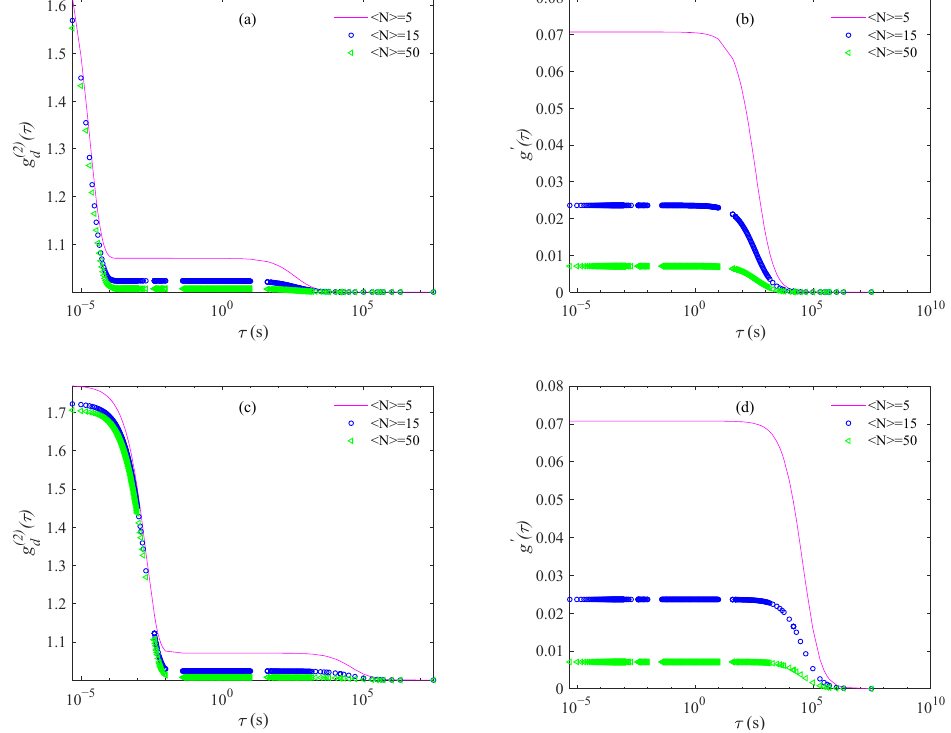
( 2 ) ( τ ) and ( b ) number fluctuation terms g (cid:48) ( τ ) for 10 nm Figure 1. Theoretical ( a ) intensity ACFs g d ( 2 ) ( τ ) and ( d ) number fluctuation terms g (cid:48) ( τ ) for 1000 nm particles at particles, ( c ) intensity ACFs g d average particle number (cid:104) N (cid:105) = 5, 15, and 50 in the scattering